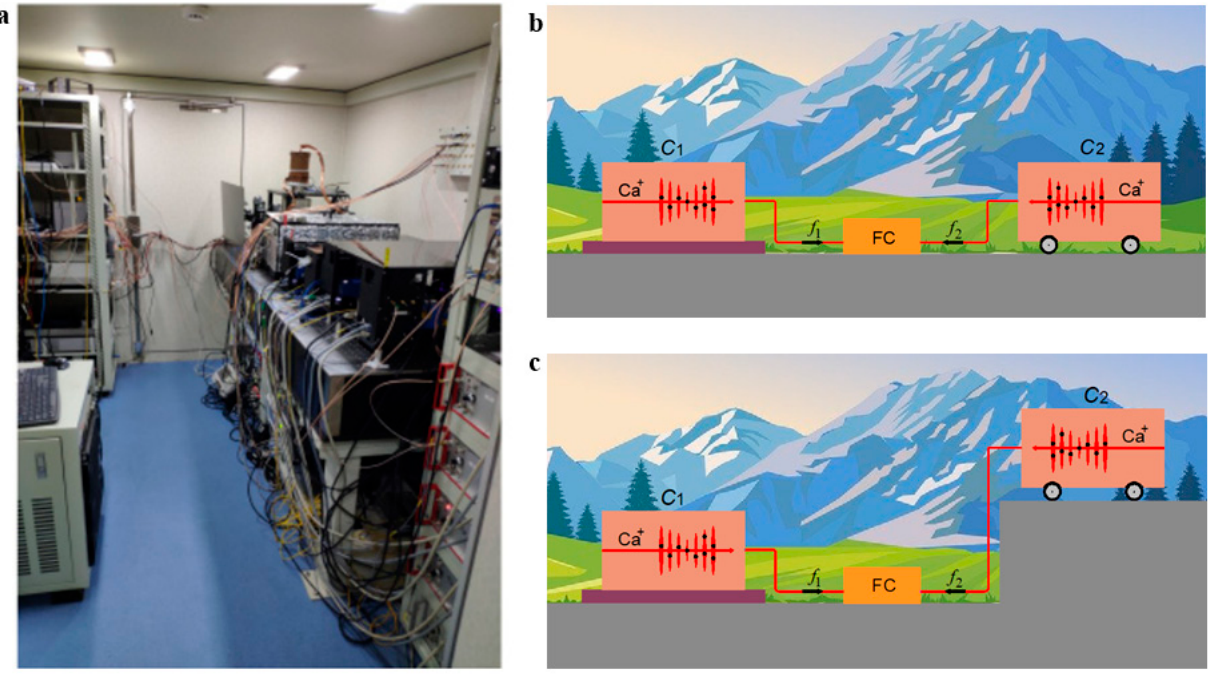
Figure 2. ( a ) Two Ca + optical clocks used located in the laboratory (courtesy of Huang et al., 2020 [26]). Scheme of experiment: ( b ) Ca + optical clocks C 1 and C 2 at same level in laboratory; ( c ) clock C 1 at laboratory level and C 2 at a height level above C 1 by 4.34 m.